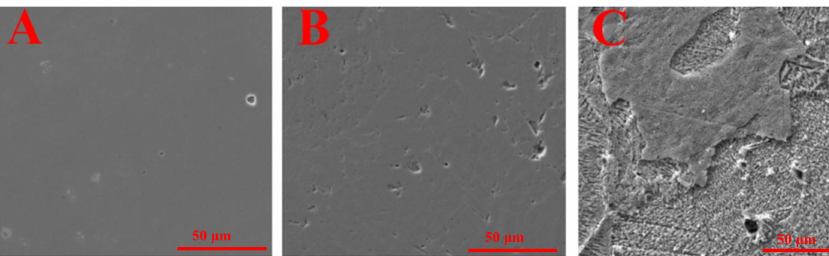
Figure 2. The potentiostatic corrosion curves with a series of gradient voltages from 0.67 V to 0.92 V.